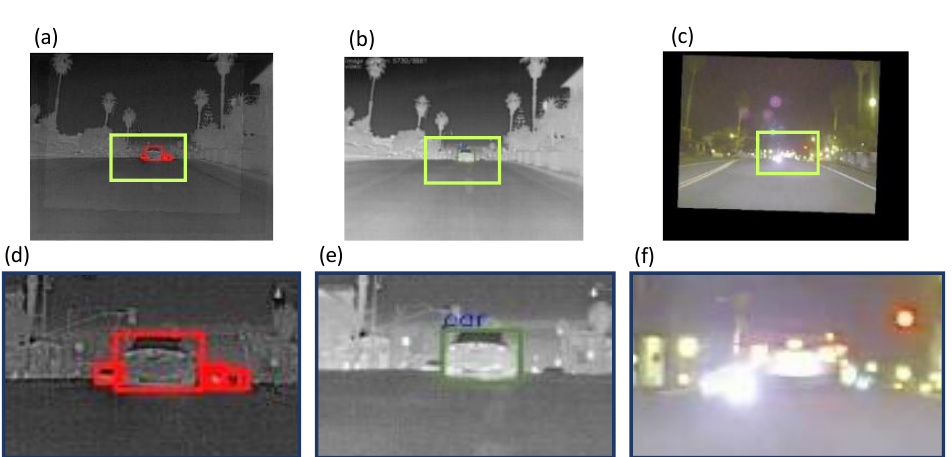
Figure 11. Image FLIR_05731: low score example of correct car classification in a night image. A subsection marked in: network classification of the RXD Anomaly Fusion image ( a ), GT image ( b ), and original RGB image ( c ), with light green boxes that are zoomed in to the region of interest, shown in images ( d , e , f ), respectively. Car objects that were detected by the network ( a , d ) are unmarked objects in GT ( b , e ).